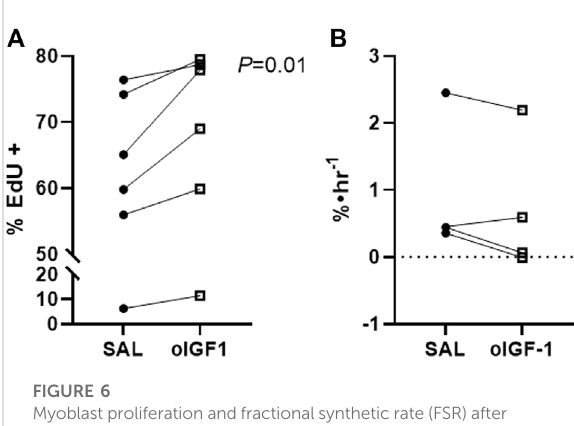
FIGURE 6 Myoblast proliferation and fractional synthetic rate (FSR) after chronic infusion of recombinant ovine IGF-1 (oIGF-1). (A) Percent of myoblasts in biceps femoris (BF) muscle that were positive for